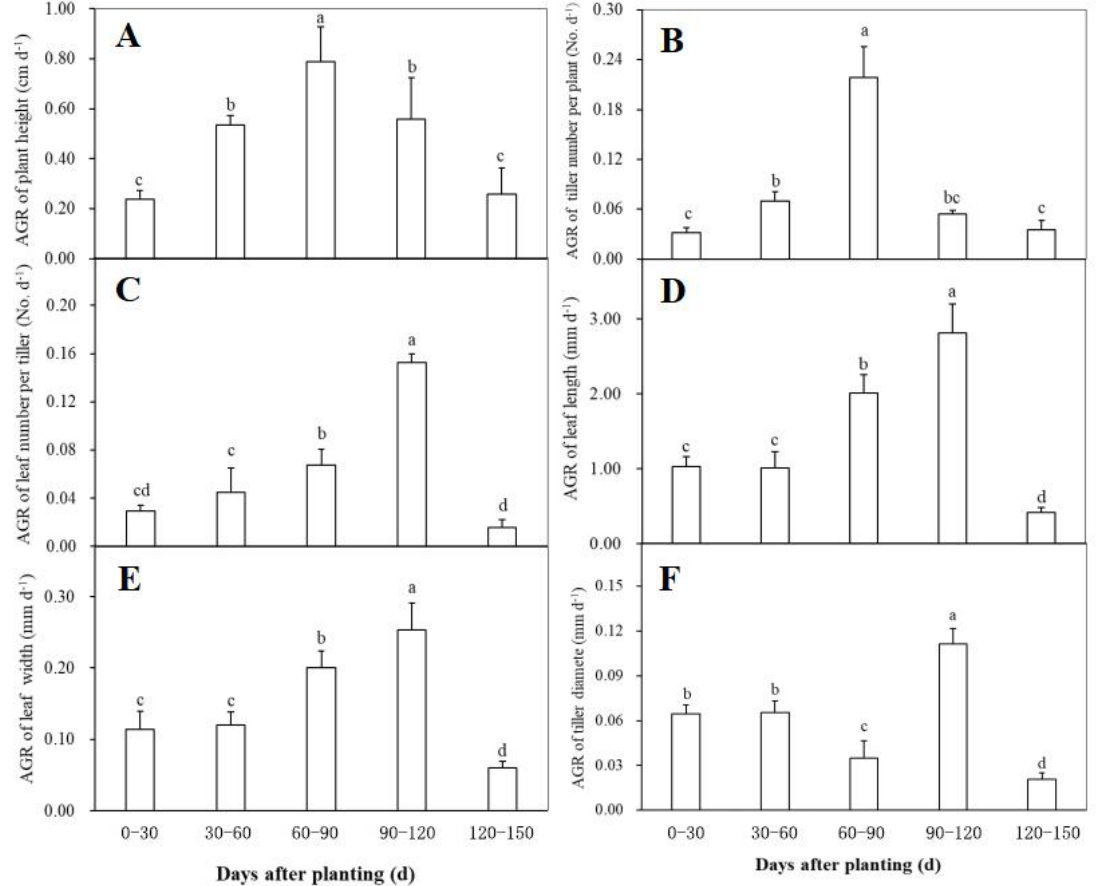
Figure 2. The relative growth rate (RGA) of plant height ( A ), tiller number per plant ( B ), leaf number per tiller ( C ), leaf length ( D ), leaf width ( E ), and tiller diameter ( F ) of the disease-free ginger plants grown in a simplified plastic greenhouse at different periods after planting. Means ± standard deviation (SD) with different letters indicate significantly difference at p < 0.05.